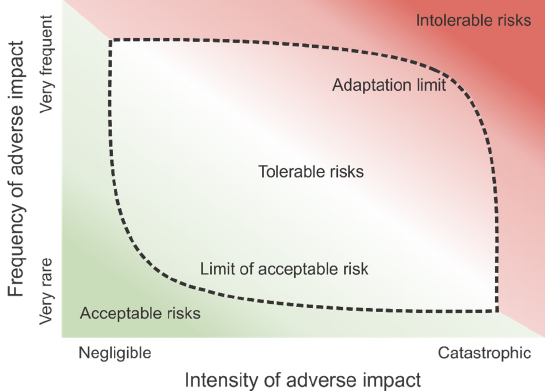
Figure 8. Risk tolerance curve is based on acceptable risks (there is no need to act), tolerable risks (risks can be managed by adaptation), and intolerable risks (risks that cannot be managed with adaptation). Modified from [94] based on [95].